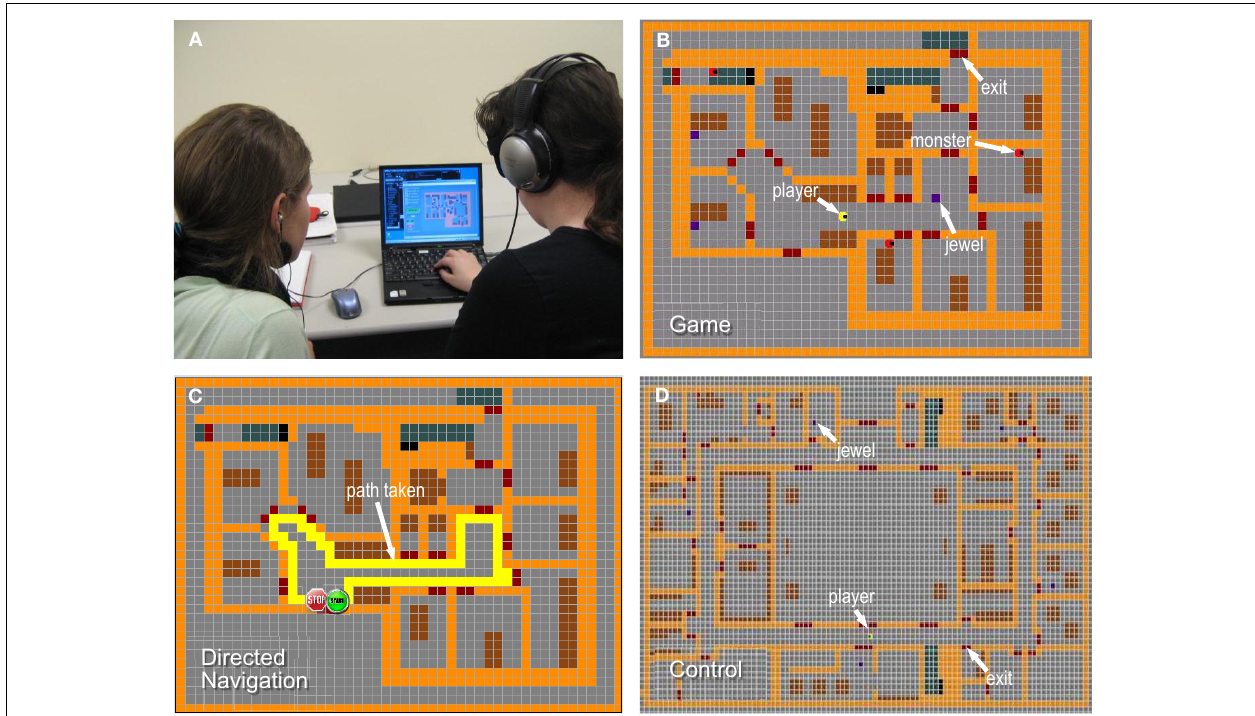
FIGURE 2 | Virtual rendering of an existing two story building (for simplicity, only the first floor is shown) represented in the AbES software used. (A) Blind participants (right) interacting with the AbES software while a facilitator (left) looks on. (B) In gamer mode, the user (yellow icon) navigates through the virtual environment using auditory cues to locate hidden jewels (blue squares) and avoid being caught by roving monsters (red